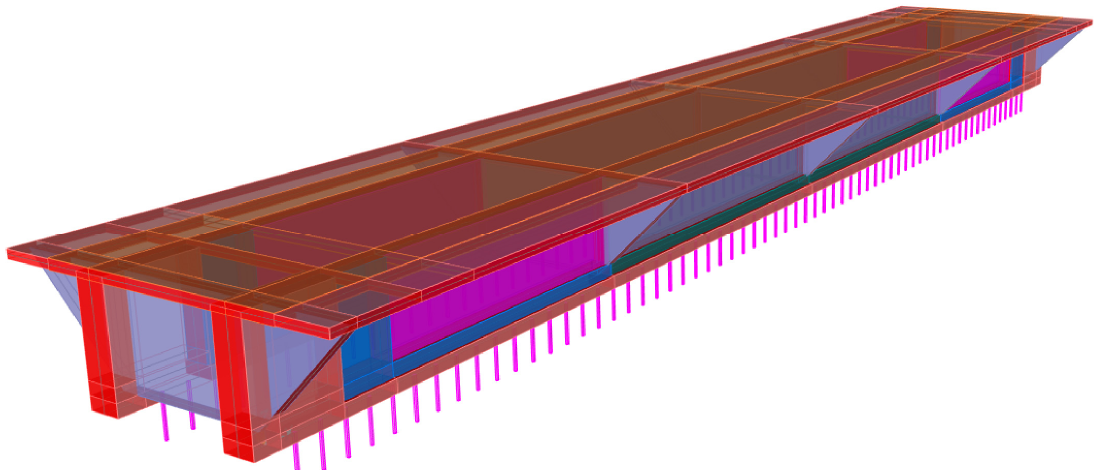
Figure 29. A 3D representation of bridge Span-2 in FE model. Figure 29. 3D representation of bridge Span-2 in FE